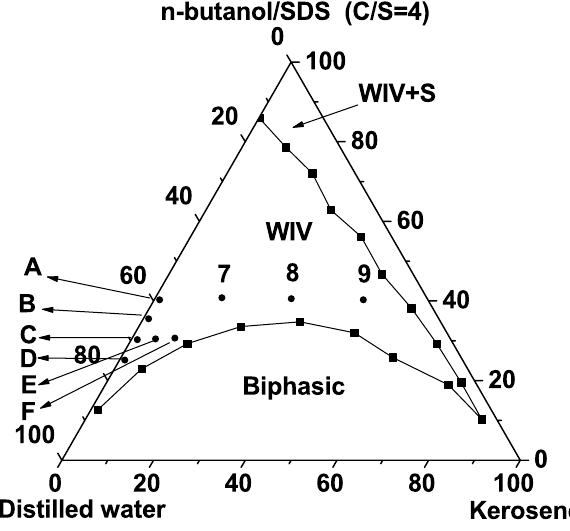
Fig. 2 Pseudoternary diagram for the formulations: A, B, C, D, E and F, used as flushing fluid for filter cake removal Table 2 Formulations and filter cake removal efficiencies for points A, B, C and D